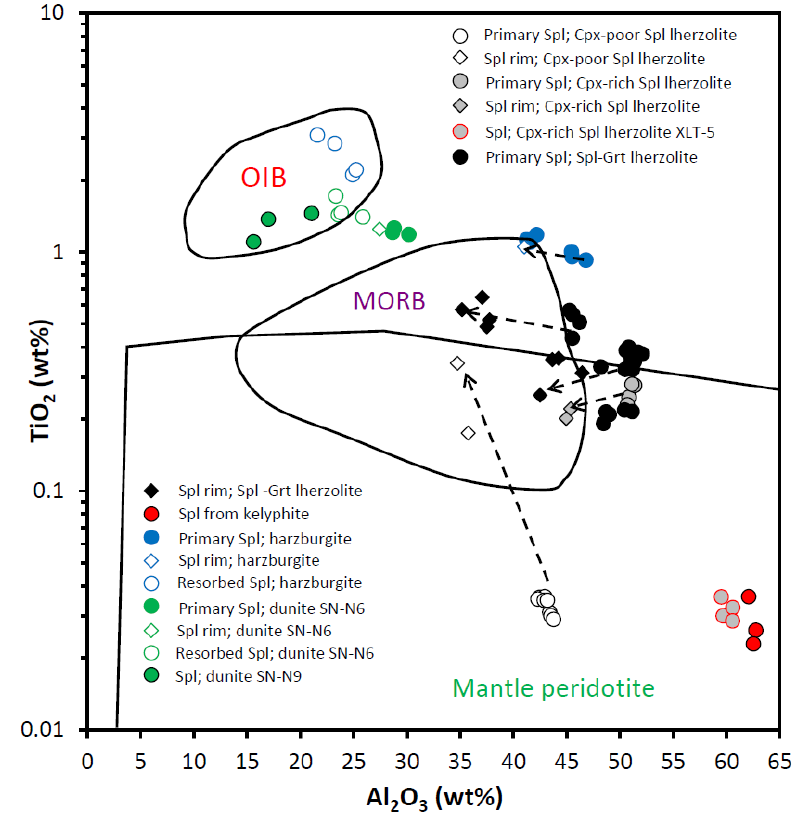
Figure 9. Diagram Al 2 O 3 (wt%) vs. TiO 2 (wt%) for spinels from the East Antarctic peridotite xenoliths. Dashed arrows connect compositions of the spinel cores and corresponding rims (see text for details). Fields for Mantle peridotite, mid-ocean ridge basalt (MORB) and ocean island basalt (OIB) spinels are after [18,21,23].